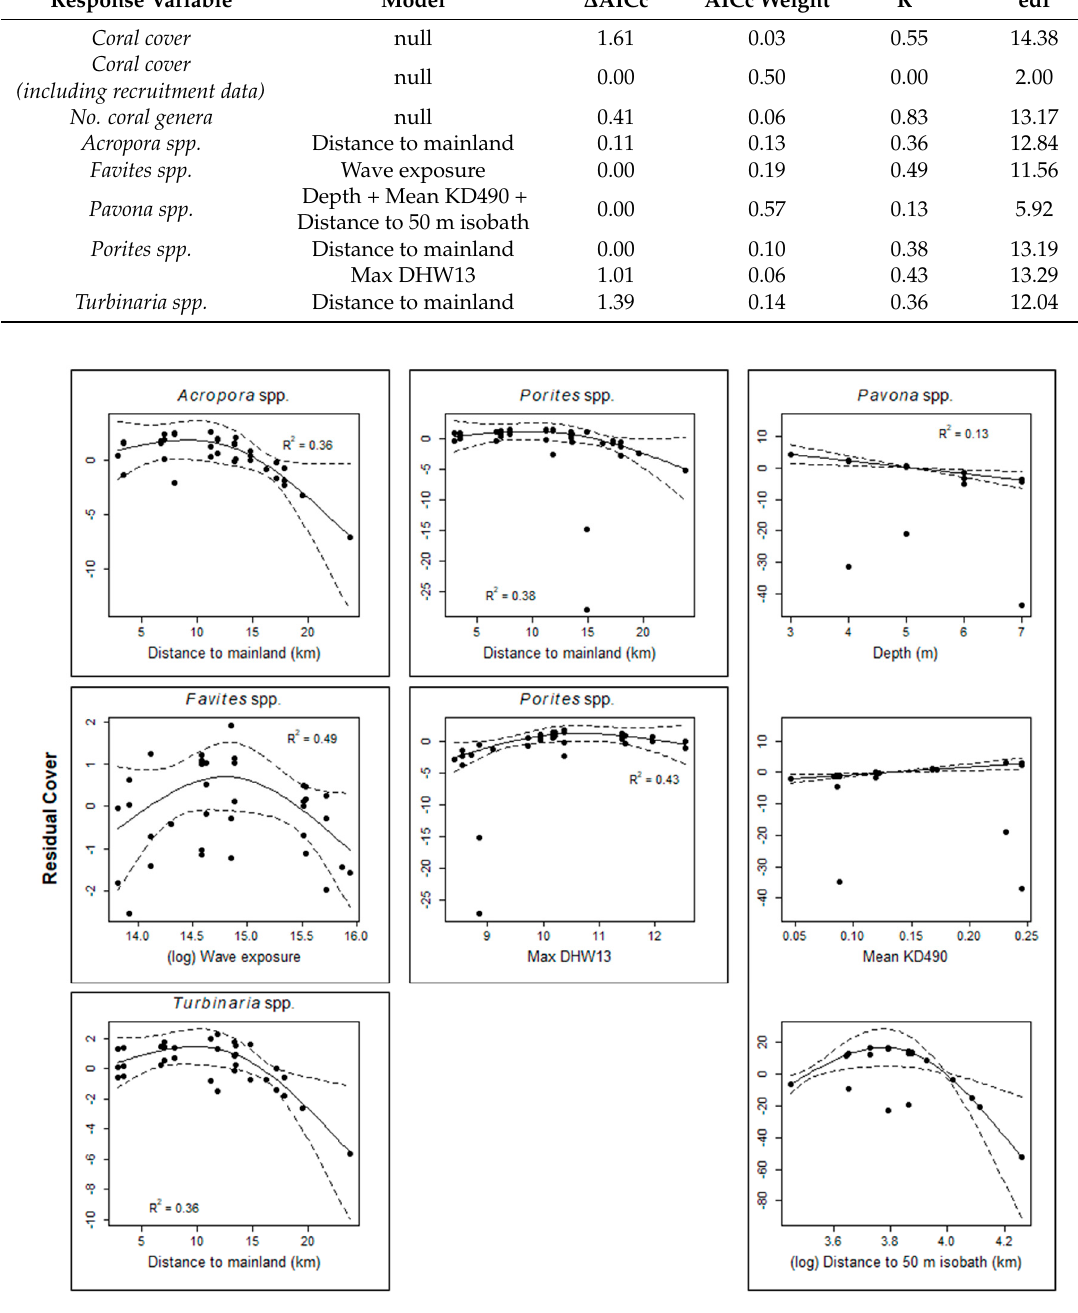
Figure 4. Best generalised additive mixed models (GAMMs) for the cover of Acropora, Favites , Pavona , Porites and Turbinaria spp. corals in the Dampier Archipelago, Western Australia (Table 2).